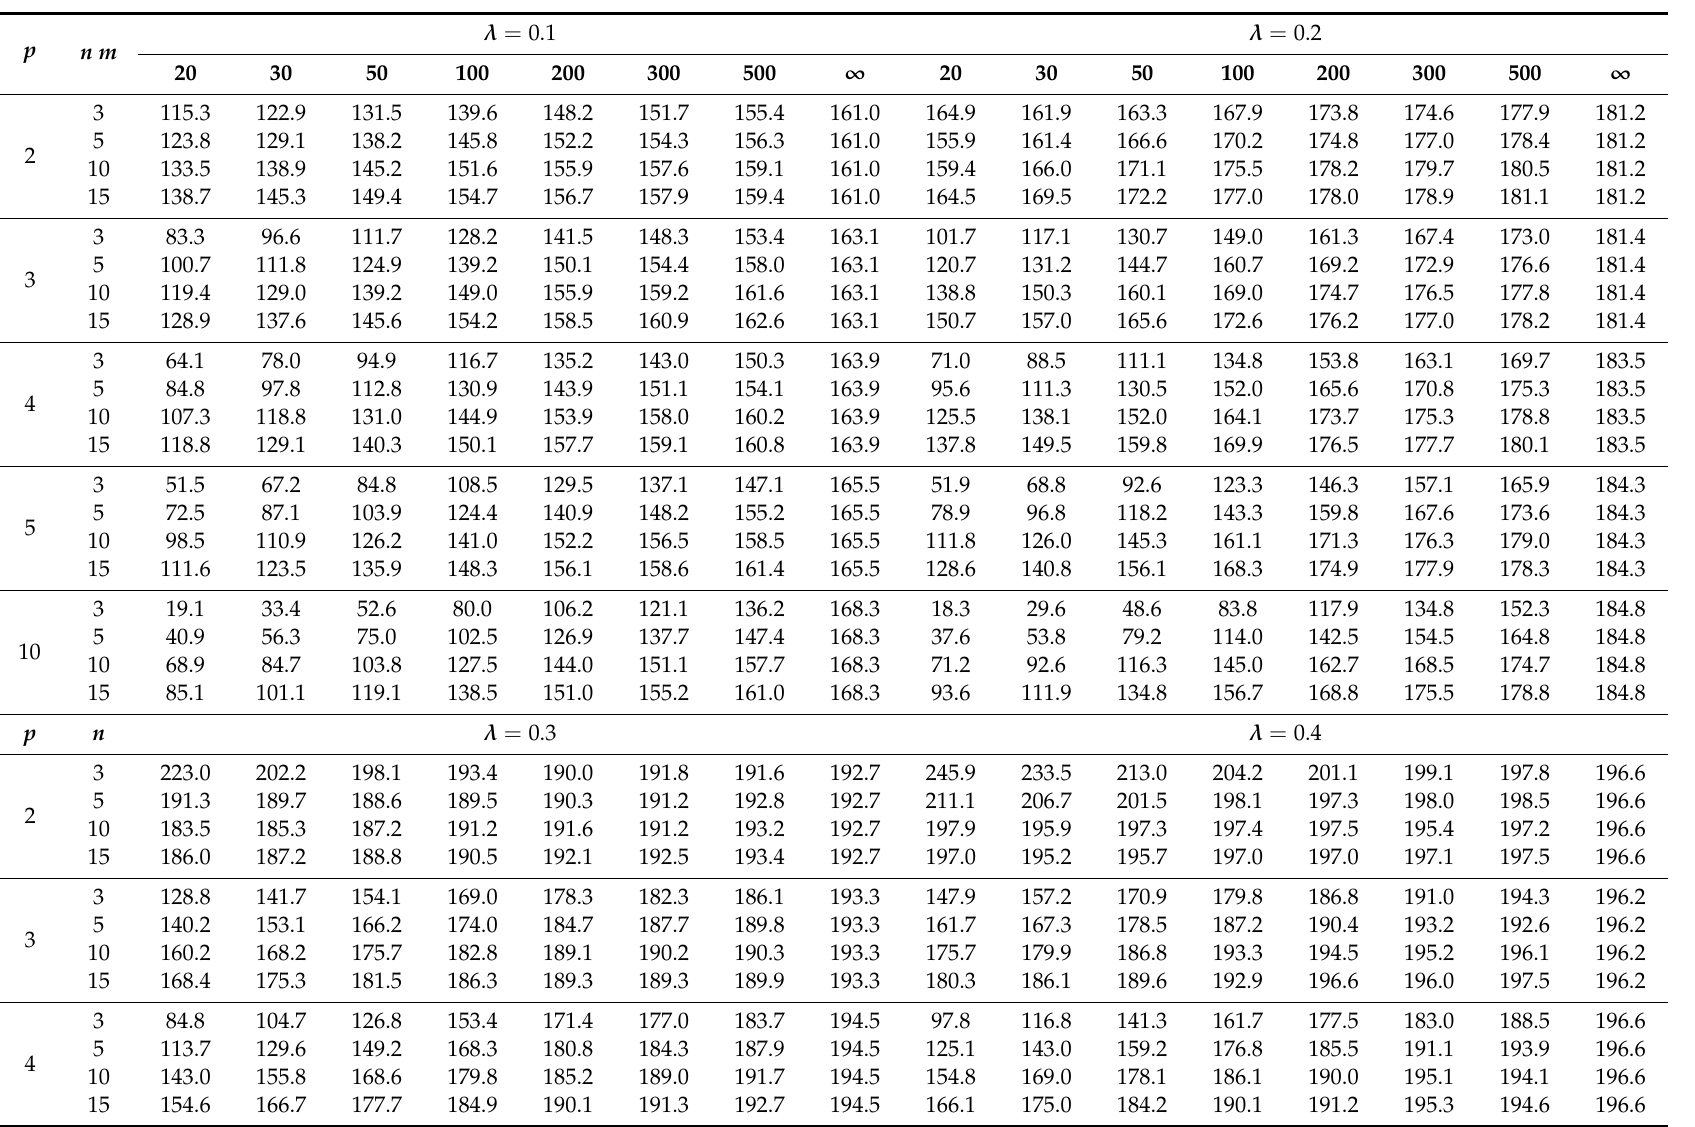
Table 6. Estimation e ff ect on SDRL 0